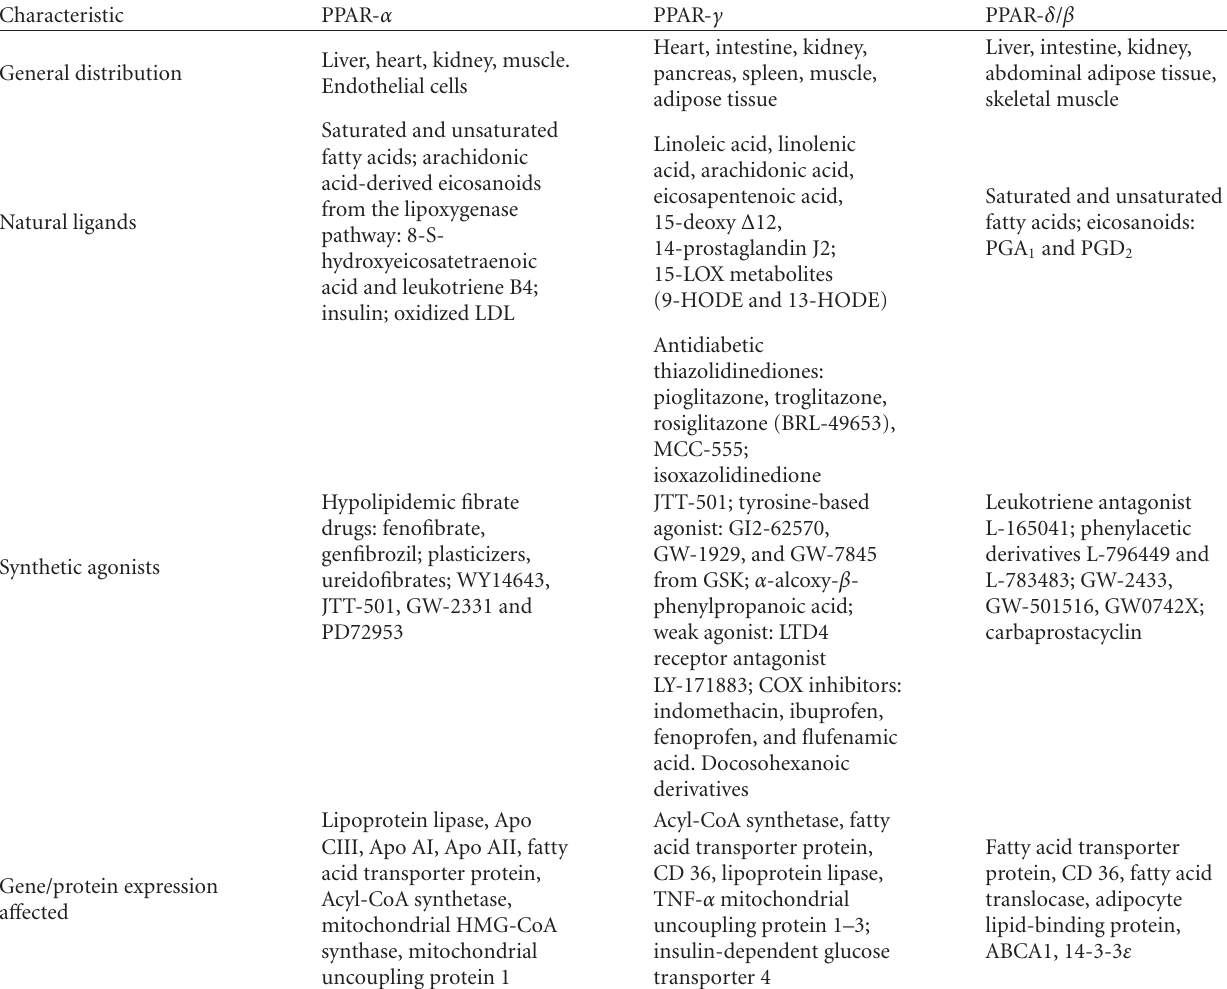
Table 1: Properties and agonists of